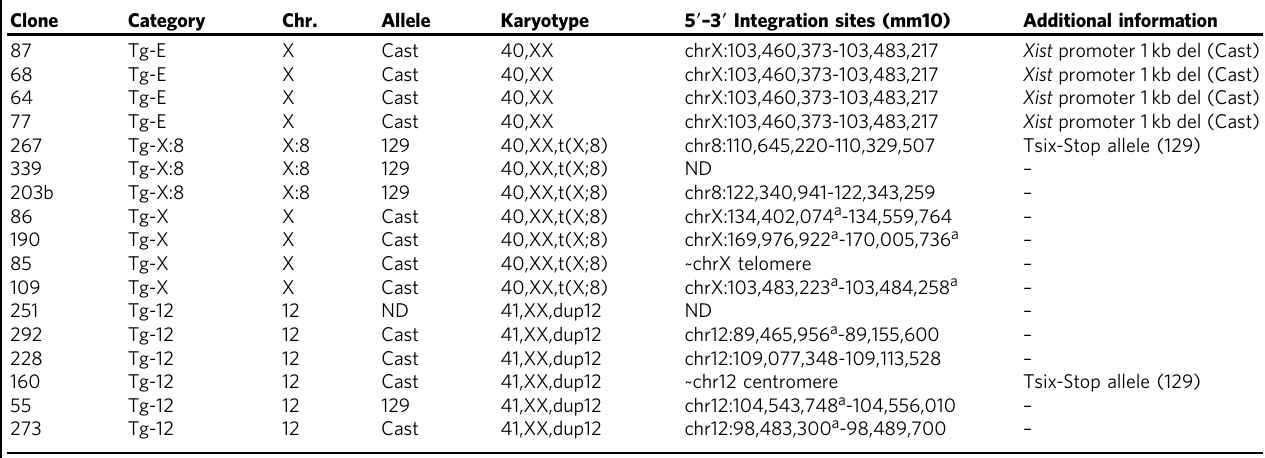
Table 1 Summary of transgenic clones generated in this study Clone